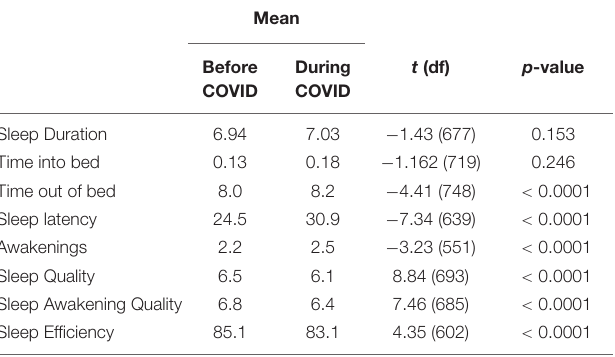
TABLE 6 | Comparisons of sleep parameters in the elderly before and during COVID.